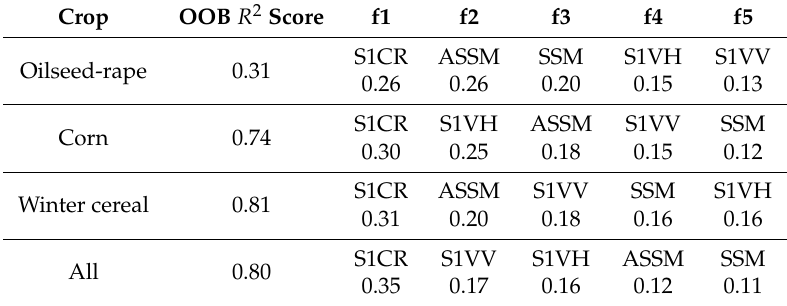
Table 3. OOB R 2 score and variable importance of Sentinel-1 CR, VH and VV, and surface soil moisture (SSM) and antecedent soil moisture averaged over three days prior (ASSM) from the RF modelling for VWC t per crop